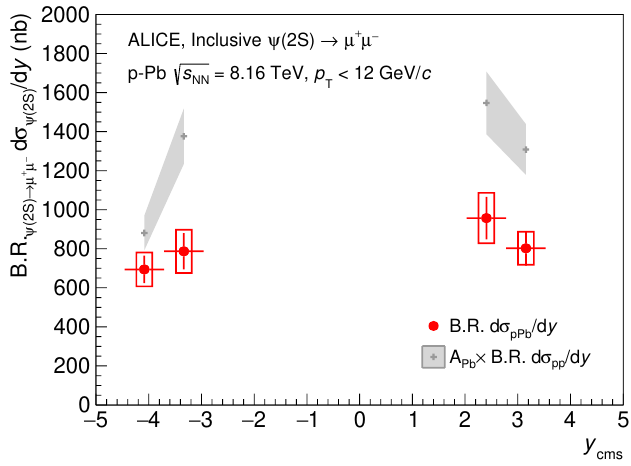
Figure 2 . The di(cid:11)erential cross section times branching ratio B : R : 12 GeV/ c . The error bars represent the statistical uncertainties, while the boxes correspond to total systematic uncertainties. The latter are uncorrelated among the points, except for a very small correlated uncertainty (0.5% and 0.7% for the forward and backward y cms samples, respectively). The grey bands correspond to the reference pp cross section scaled by A Pb